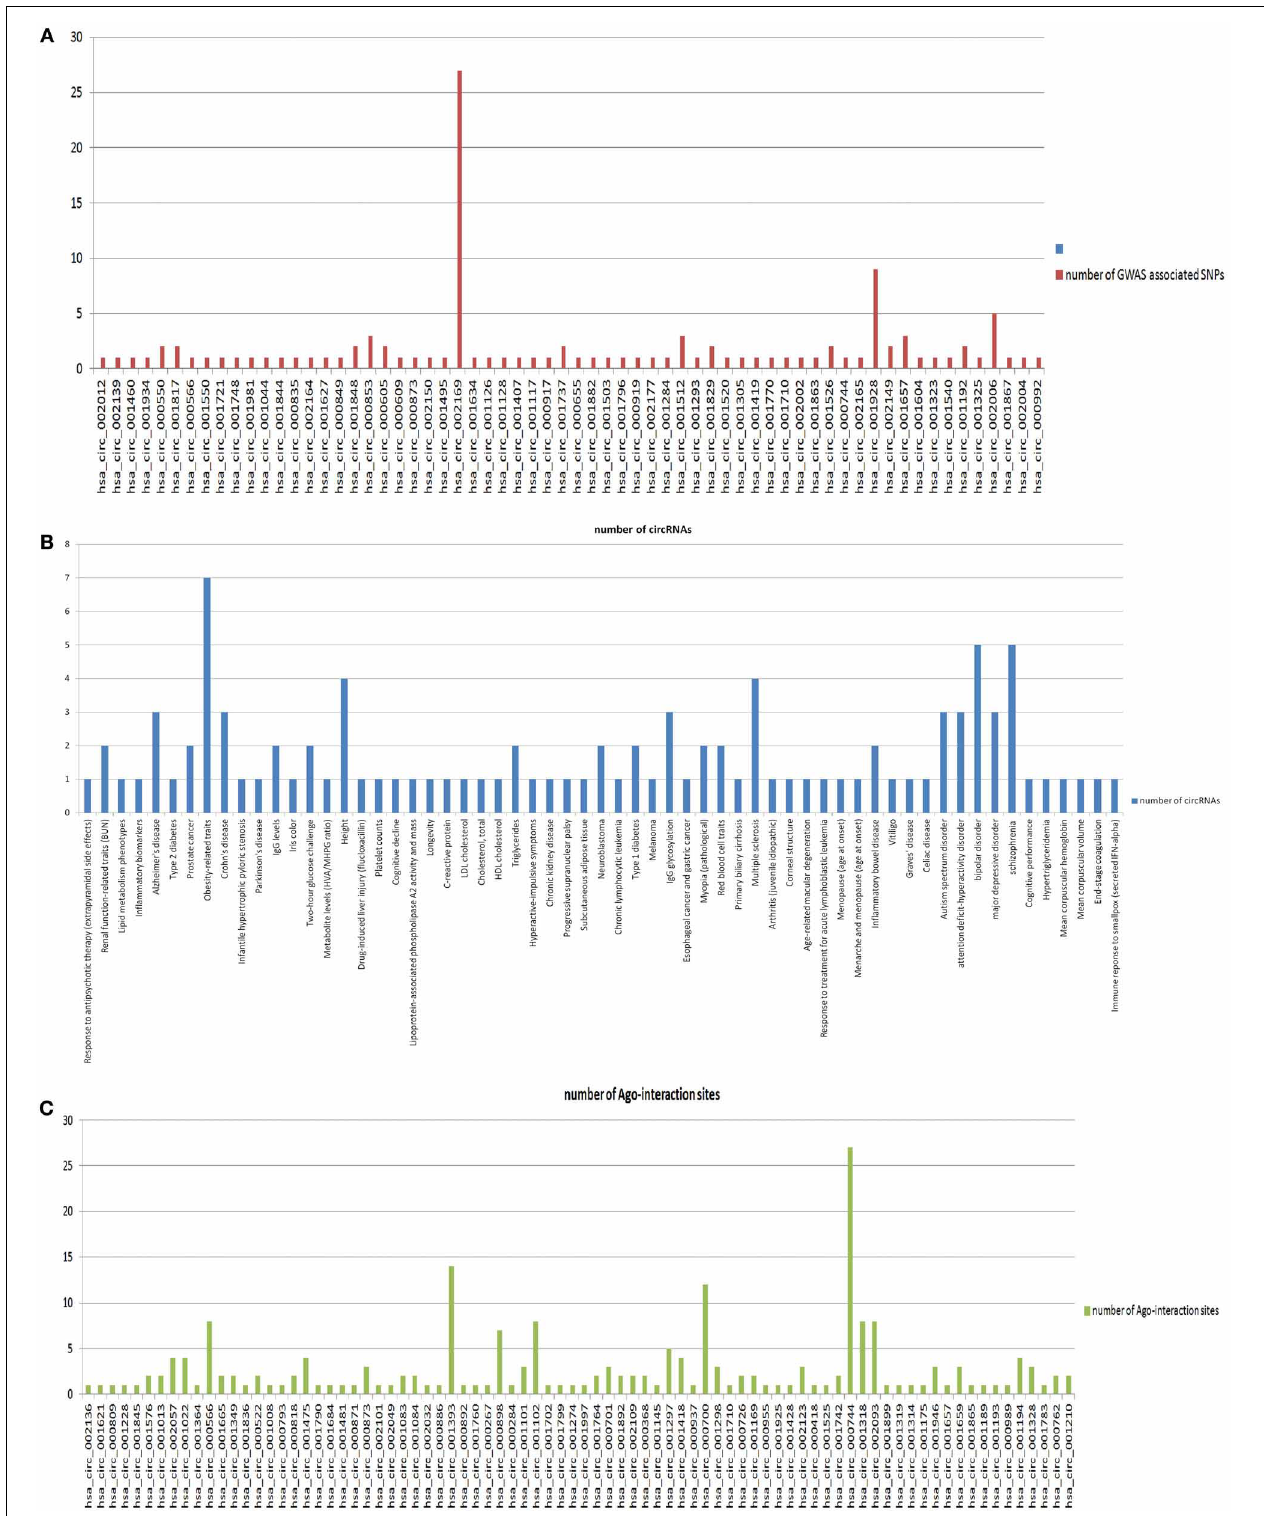
FIGURE 3 | (A) The number of traits associated SNPs mapped into each of the 64 circRNAs. (B) The distribution of circRNAs associated with these 61 different traits. (C) The distribution of Ago interacting sites on 82 circRNAs.